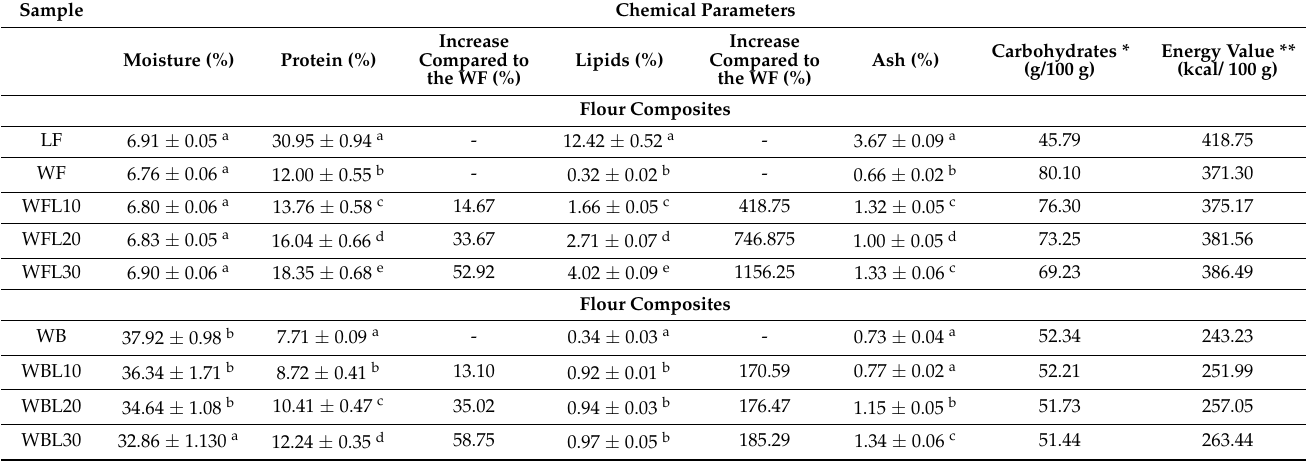
Table 2. Proximate composition of lupin flour composites and